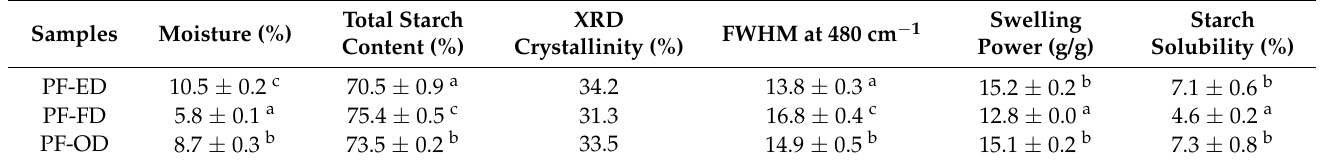
Values are means ± SD. Values with the different letters in a column are significantly different ( p <